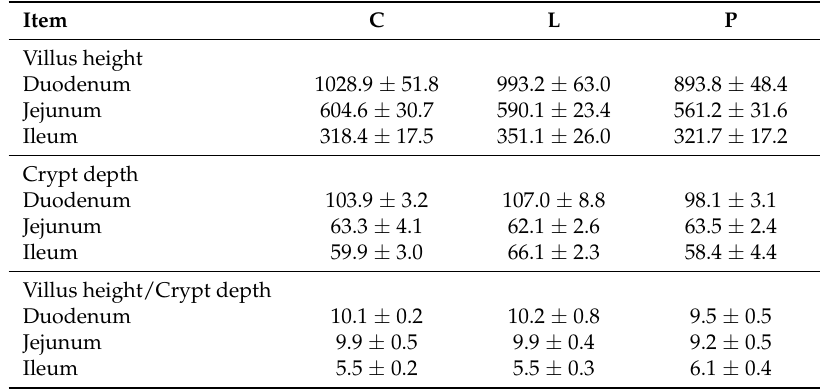
Table 6. Villus height, crypt depth and goblet cell density in the small intestine of laying hens in samples collected during the last day of the experiment ( n = 10).